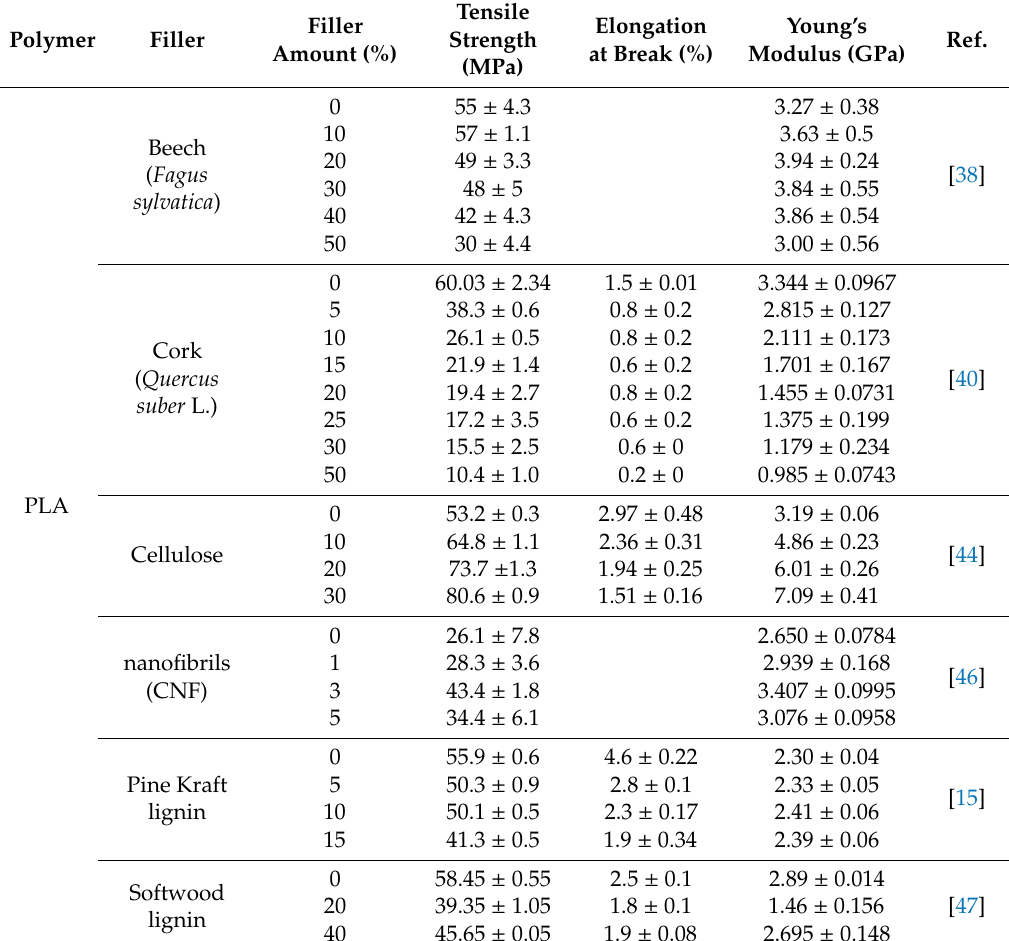
Table 3. Mechanical properties of wood and lignocellulosic filled poly(lactic acid) composites collected using tensile testing data from selected